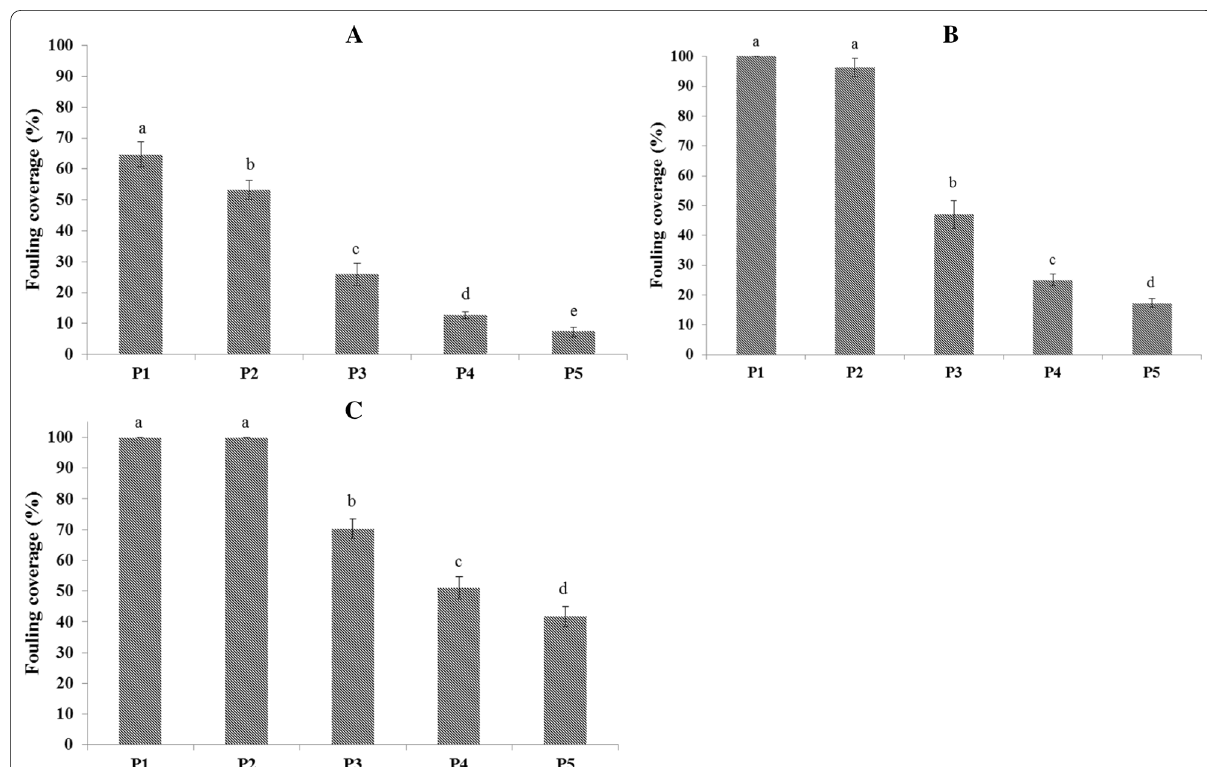
Fig. 3 Fouling coverage (%) after immmersion in seawater for one ( A ), two ( B ) and three ( C ) month(s) in Bandar-e-Gorzeh, Persian Gulf. P1: uncoated panel (control); P2: panel coated with PCL (100%); P3: panel coated with PCL 100% / antifoulant 10 phr; P4: panel coated with PCL